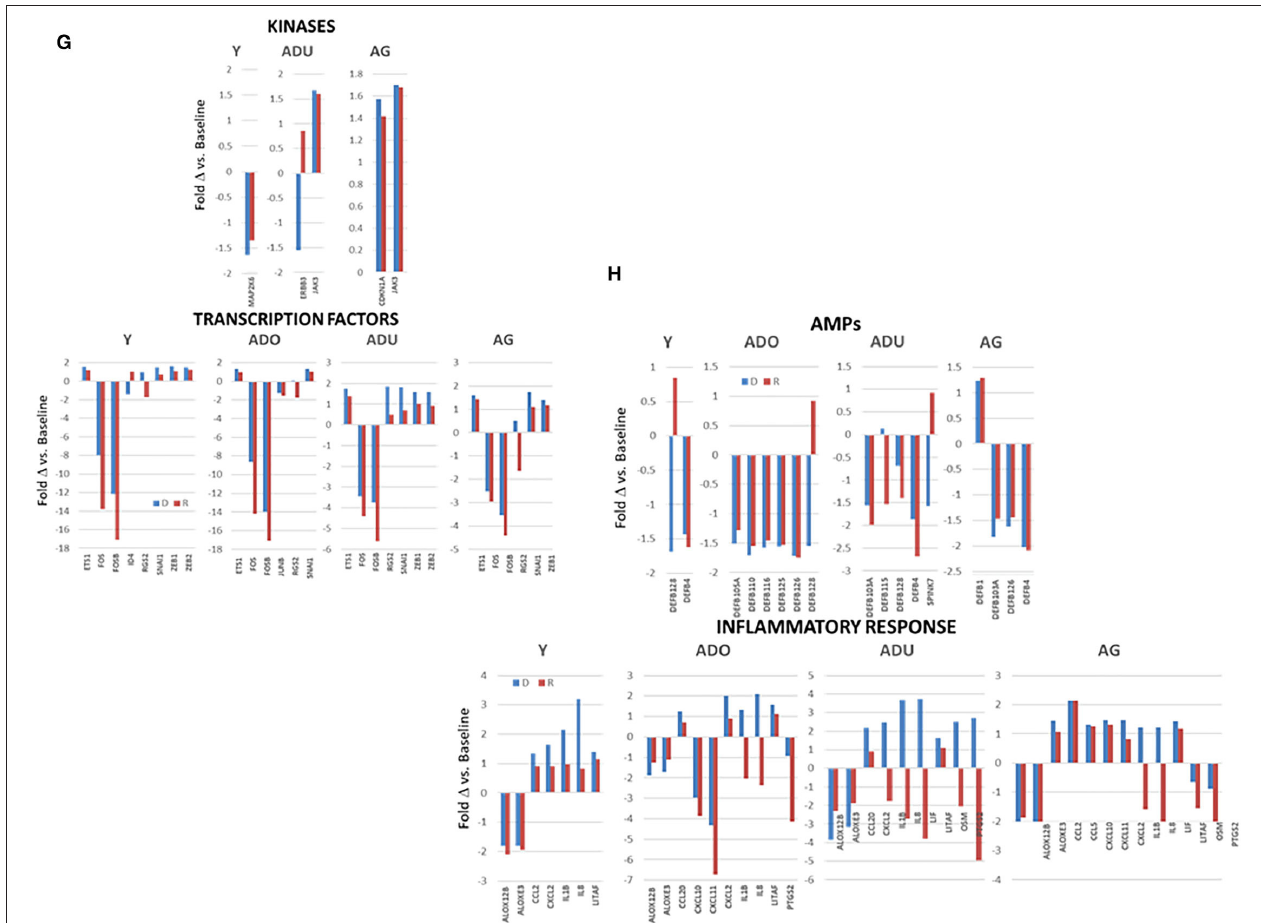
FIGURE 5 | (A–H) Bars denote fold-difference of genes in each of the functional categories that were expressed at > 1.5-fold in disease (D) or resolution (R) tissues compared to healthy baseline levels for each age group.